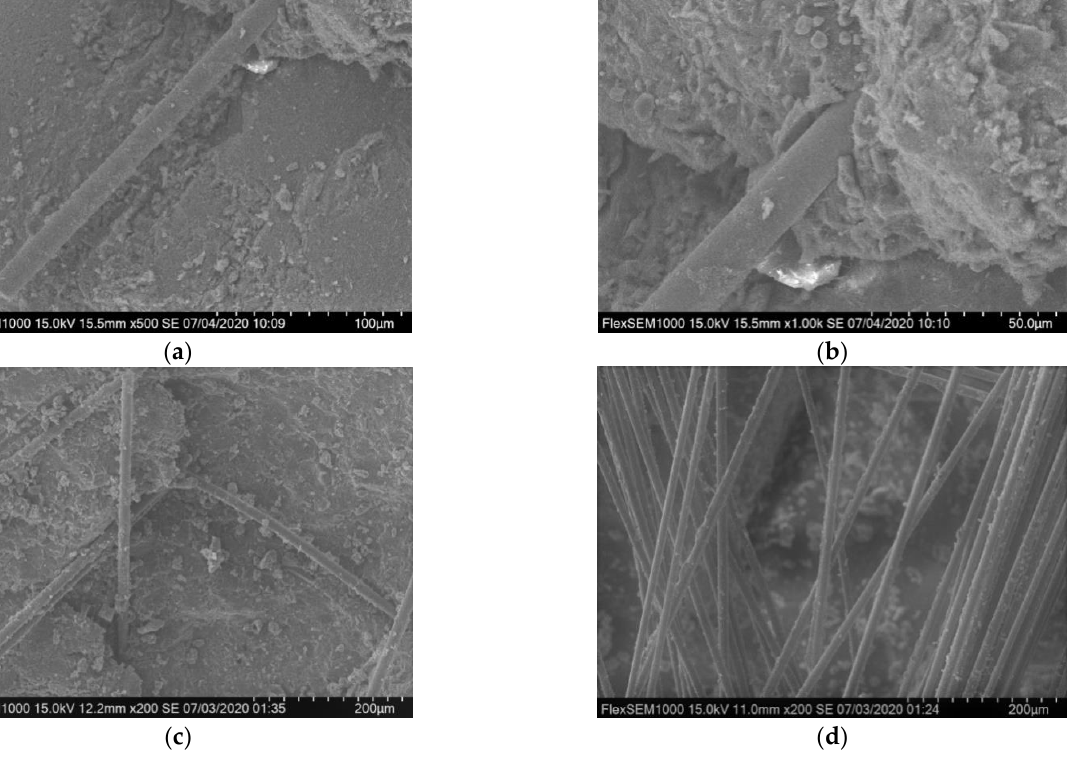
Figure 7. Microstructure of 28 d samples: ( a , b ) fiber and cement matrix bonding morphology, ( c ) fiber slip phenomenon, ( d ) fiber distribution structure characteristics in the matrix.